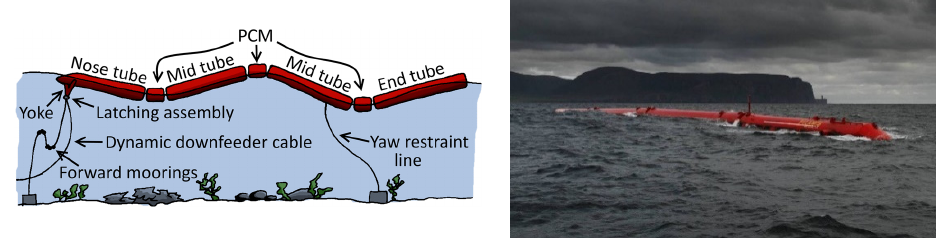
Figure 24. Working principle [82] and external view of Pelamis [83].